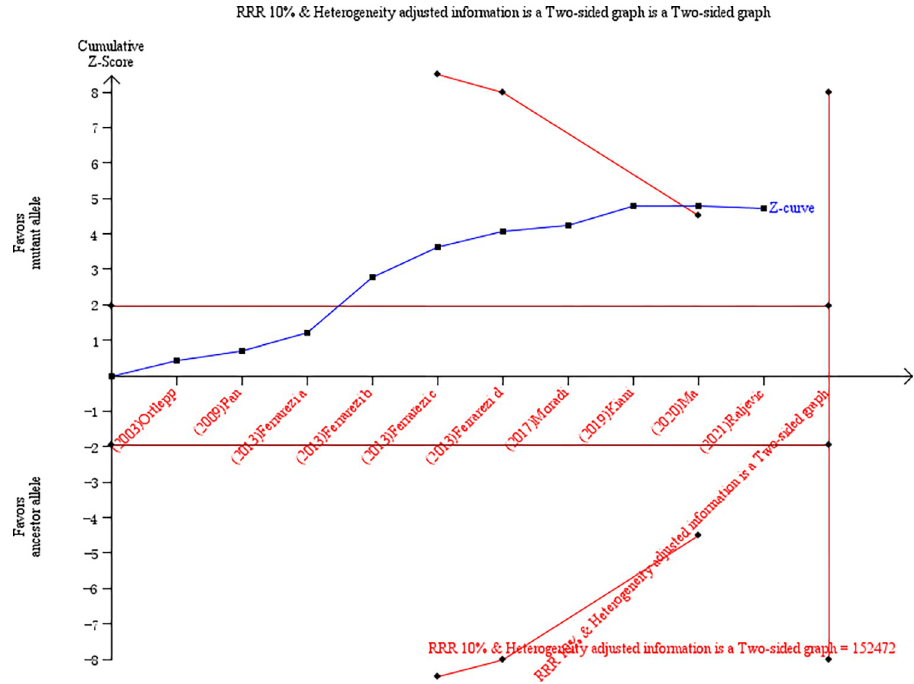
Fig 5. Trial sequential analysis of VDR rs1544410 polymorphism in overall population. VDR = vitamin D receptor.